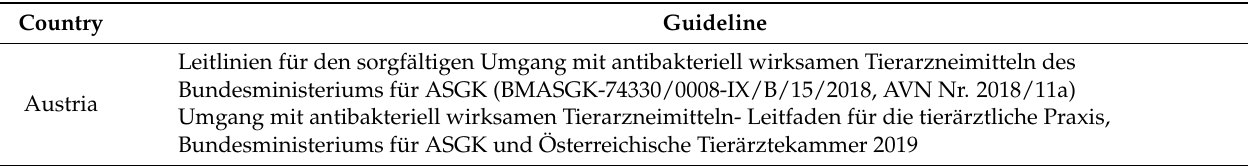
Table 1. Summary of guidelines for antibiotic use. Country